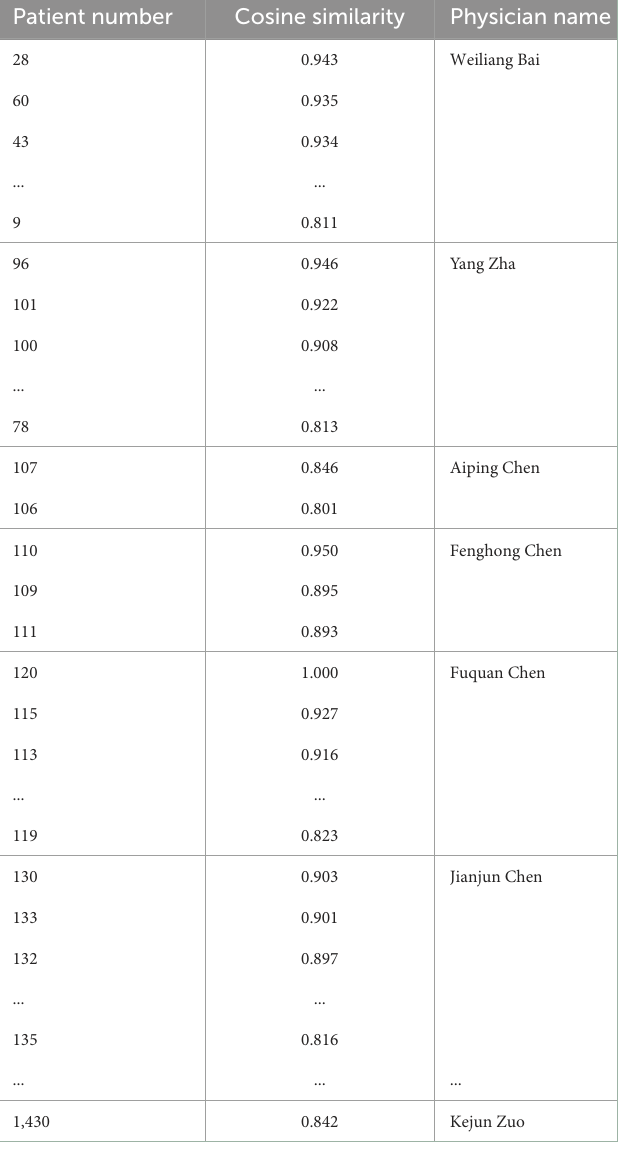
TABLE 8 Similar patients and physicians of target patient 120. TABLE 9 One hundred and twenty target patient recommendation results based on similar